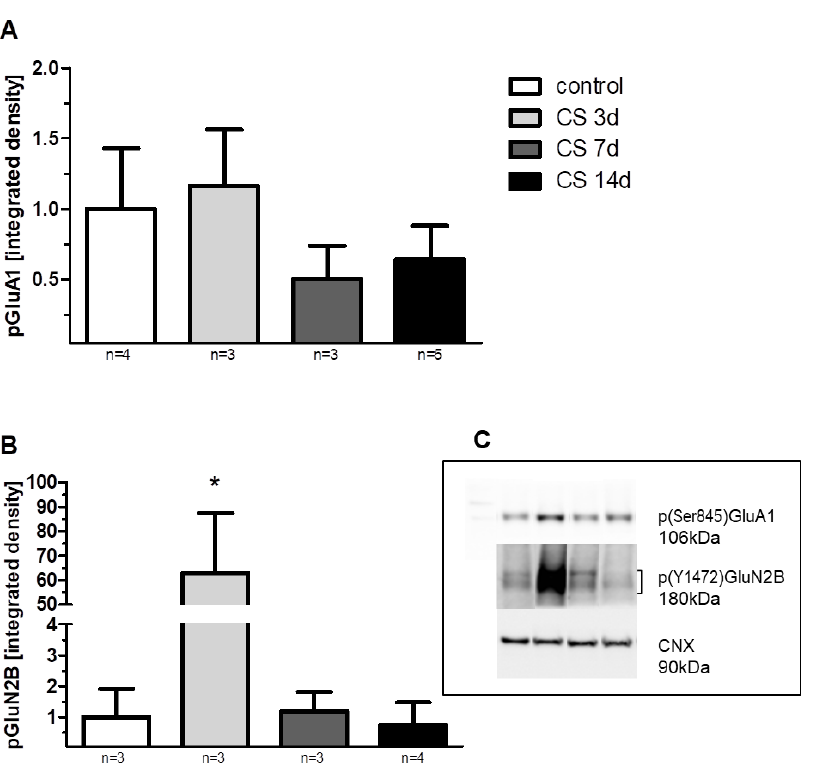
Figure 7. The influence of crowding stress (CS) and its duration on the phosphorylation level of the GluA1 subunit of the AMPA receptor ( A ), GluN2B subunit of the NMDA receptor ( B ). ( C ) Representative immunoblots that illustrate GluA1 and GluN2B phosphorylation levels in the FC of all studied groups. Bands’ order from the left: molecular weight marker; control; CS 3d; CS 7d; CS 14d. Data were calculated as percentages of controls and are expressed as means ± SEM. A one-way ANOVA revealed that the phosphorylation of GluN2B at tyrosine(Y)1472 was significantly elevated in the CS 3d group vs. the other groups [F(3, 9) = 7.31; * p < 0.05].